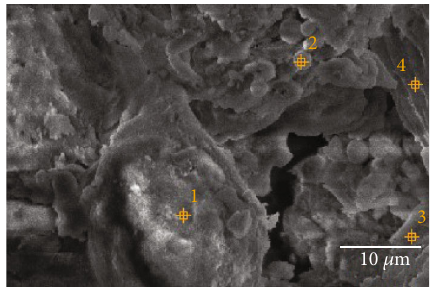
Figure 9: Element analysis point